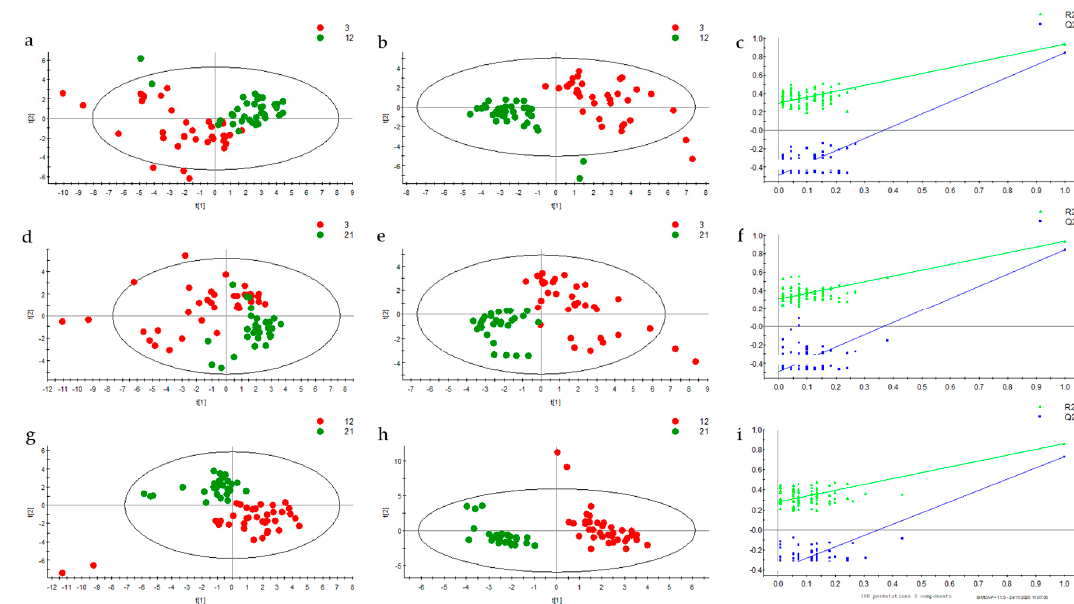
Figure 2. ( a ) PCA scores plot between 3 (red) and 12 months (green), ( b ) corresponding PLS-DA scores plot, ( c ) corresponding permutations plot, ( d ) PCA scores plot between 3 (red) and 21 months (green) ( e ) corresponding PLS-DA scores plot, ( f ) corresponding permutations plot, ( g ) PCA scores plot between 12 (red) and 21 months (green), ( h ) corresponding PLS-DA scores plot, ( i ) corresponding permutations plot.